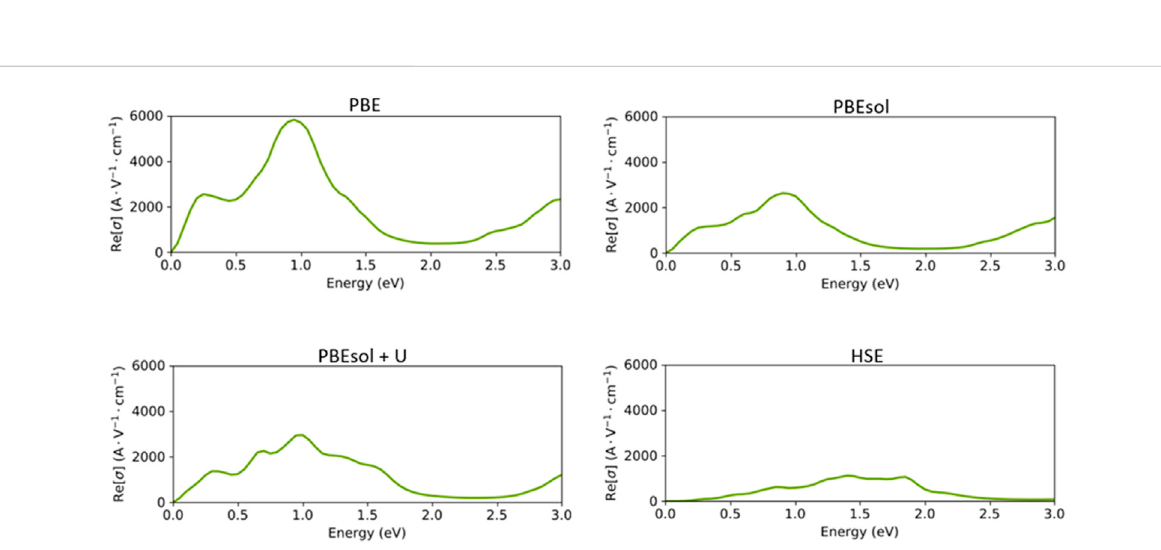
Figure 6 shows that by employing the functional from PBE to HSE, the adsorption spectrum upshifted to higher energies from the far-infrared to the near-infrared ranges of light, while the corresponding adsorption coef fi cient decreased from 6.1 ×